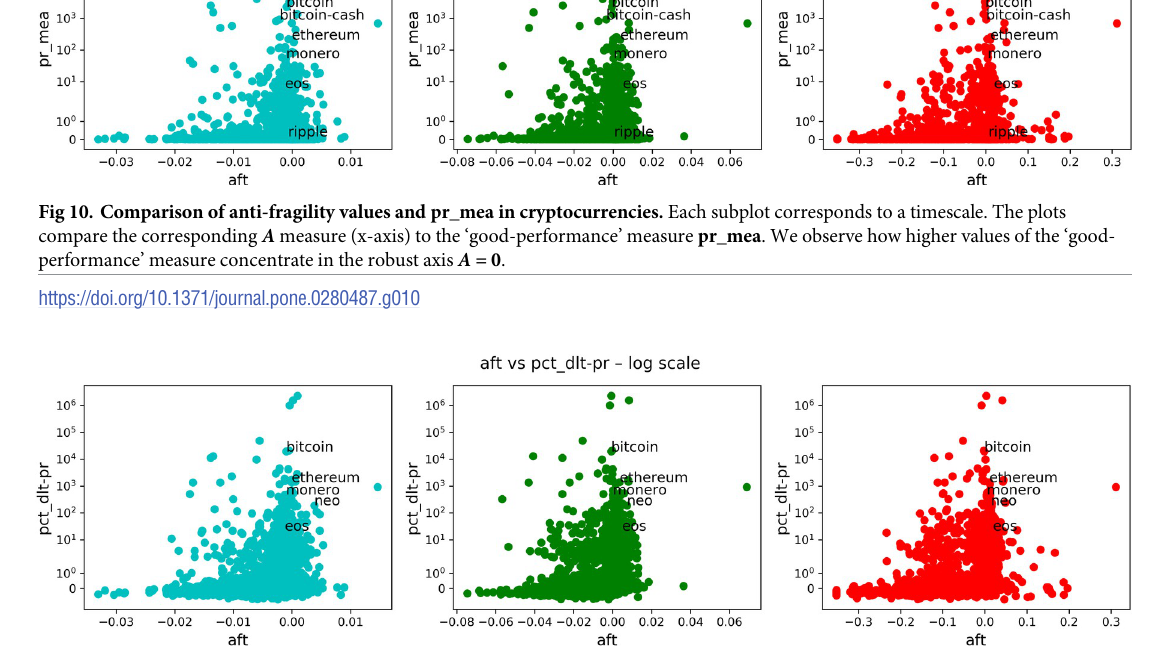
Fig 11. Comparison of anti-fragility values and pct_dlt-pr in cryptocurrencies. Each subplot corresponds to a timescale. The plots compare the corresponding A measure (x-axis) to the ‘good-performance’ measure pct_dlt-pr . We observe how higher values of the ‘good-performance’ measure concentrate in the robust axis A = 0